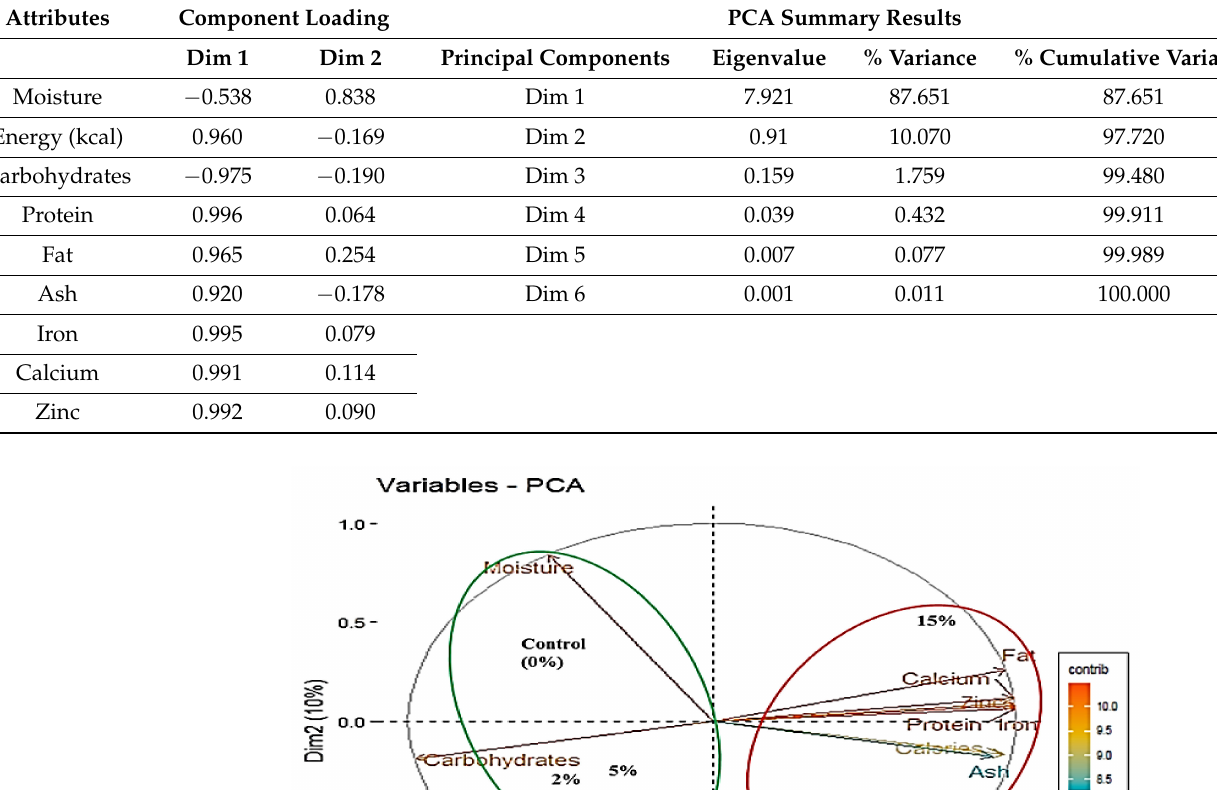
Table 3. PCA results based on different nutritional parameters of different formulations of Spirulina biomass enriched pasta.